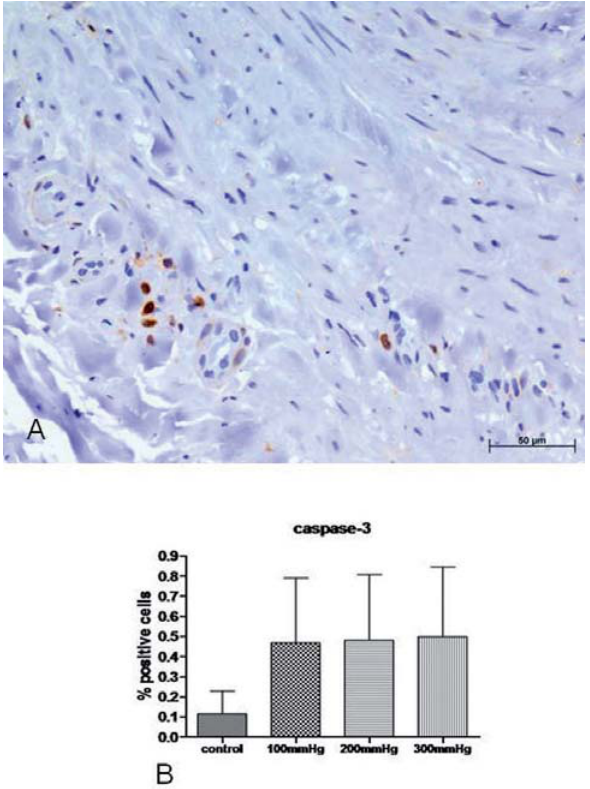
Fig. 2 - Representative photomicrograph of immunohistochemical analysis for expression of caspase 8 in segments of vein submitted for fifteen seconds at 300 mmHg (A): original magnification